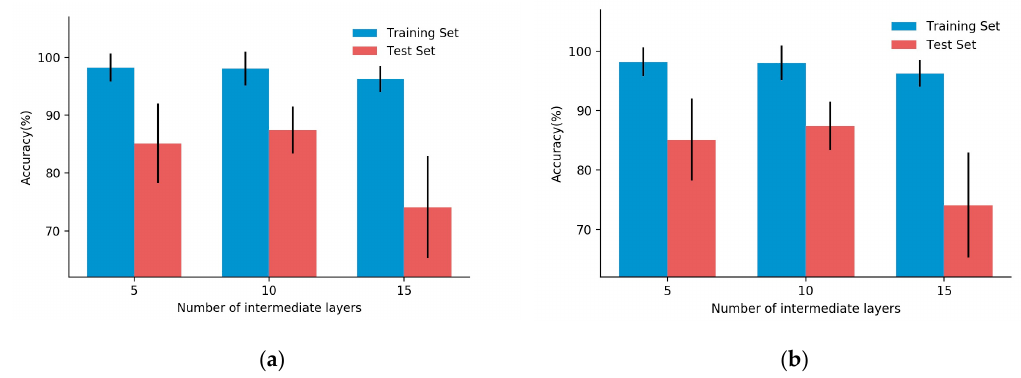
Figure 13. Comparison of accuracy with different numbers of intermediate layers by LCCDNNs. ( a ) C. elegans dataset, ( b ) zebrafish dataset.